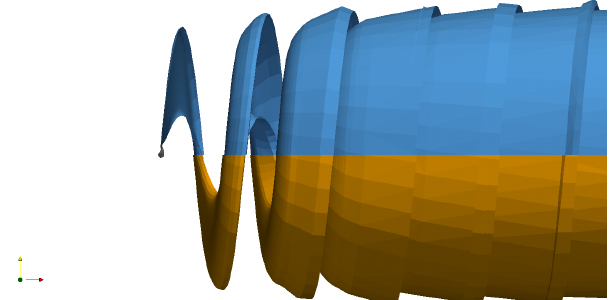
Figure 27. Wake for real (top, blue) and pseudo (bottom, orange) surge motion at f = 1Hz. Only one blade shown.